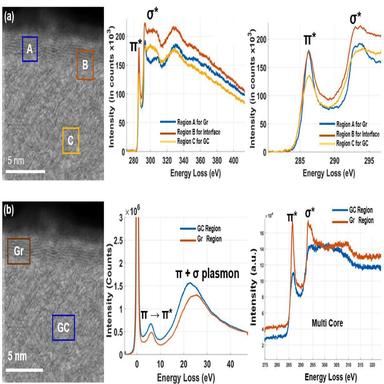
(a) Bright-field STEM image of stacked Gr layers and EELS recorded at locations A, B and C where 'A' represents Gr region, 'B' a transitional interface region, and 'C', a predominantly GC zone. (b) Summed low-loss EELS and multi-acquire high-loss EELS acquired at Gr and GC regions. (A colour version of this figure can be viewed online.)